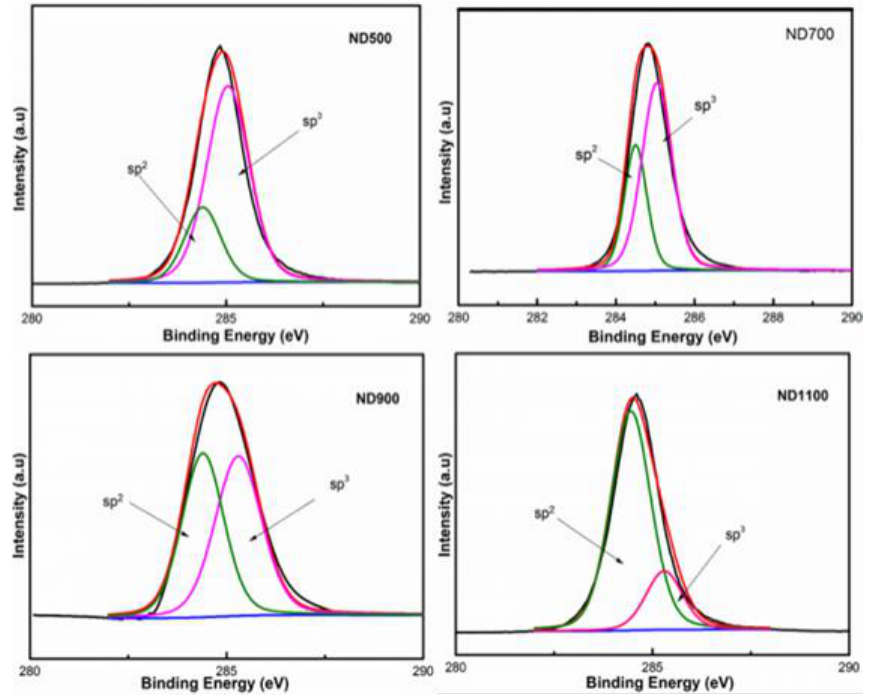
Figure 3. XPS deconvolution of C1s for ND500, ND700, ND900, and ND1100 catalysts. Table 3. BET analysis of ND500, ND700, ND900, and ND1100